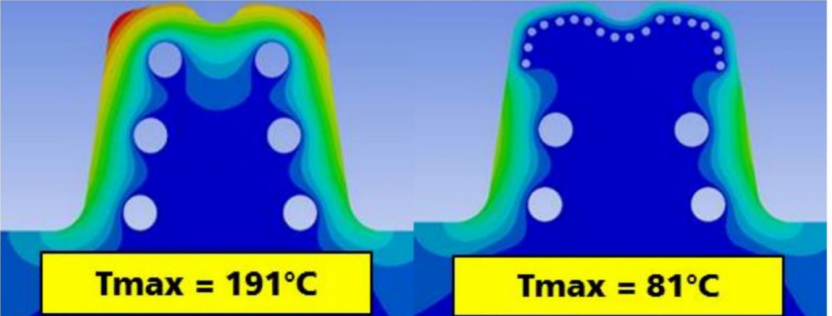
Figure 18. The temperature distribution in the hot stamping punch: ( left ) the conventional tool and ( right ) the tool designed for and made by L-PBF